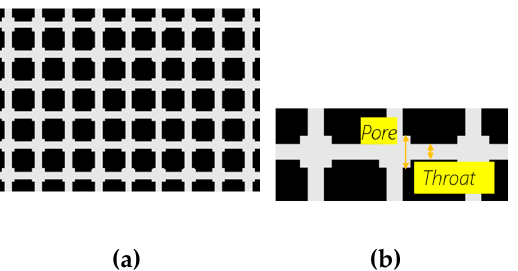
Figure 4. Design of the inlet geometries.